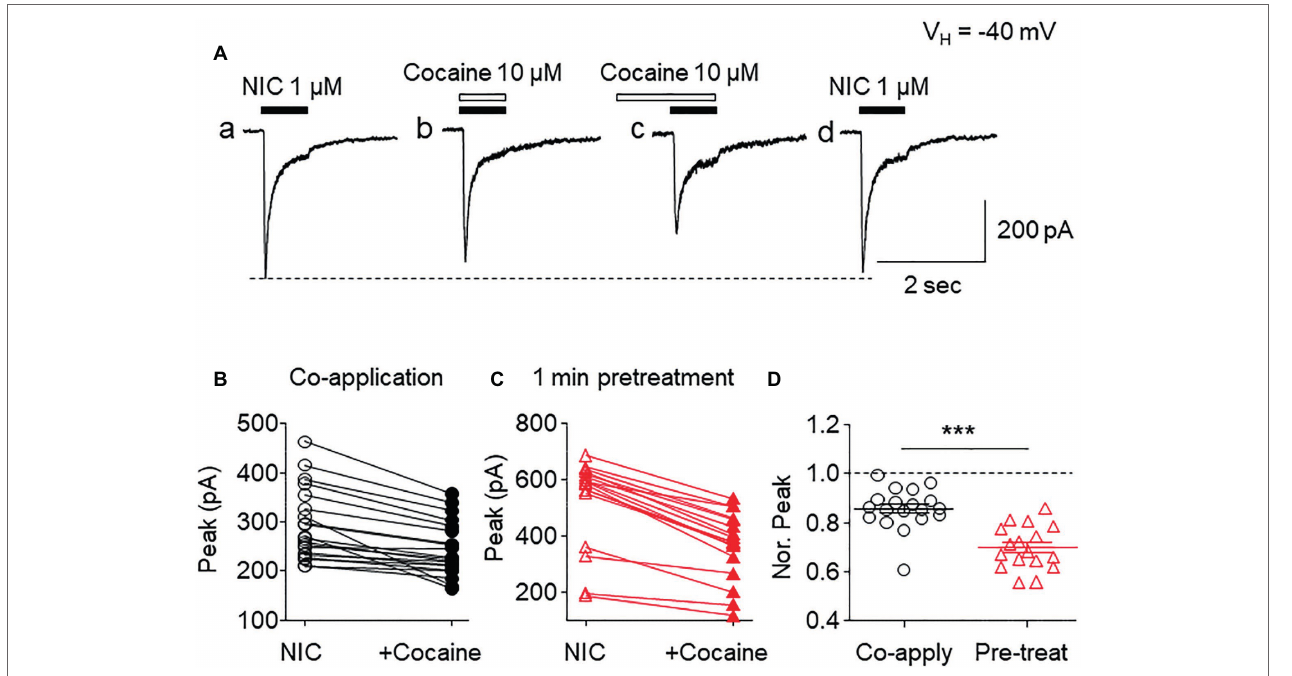
FIGURE 1 | Effects of acute cocaine on α 6*-nAChR-mediated whole-cell currents. (A) Representative traces of nicotine (NIC)-induced inward currents before and after cocaine exposure. The effects of cocaine on NIC-induced currents (peak amplitude) were compared when cocaine was co-applied with NIC (B) or with 1-min cocaine pre-application (C) . (D) Statistical comparison of the inhibitory rate of cocaine on NIC-induced current (normalized peak amplitude) between co-application and pretreatment of cocaine. *** p <